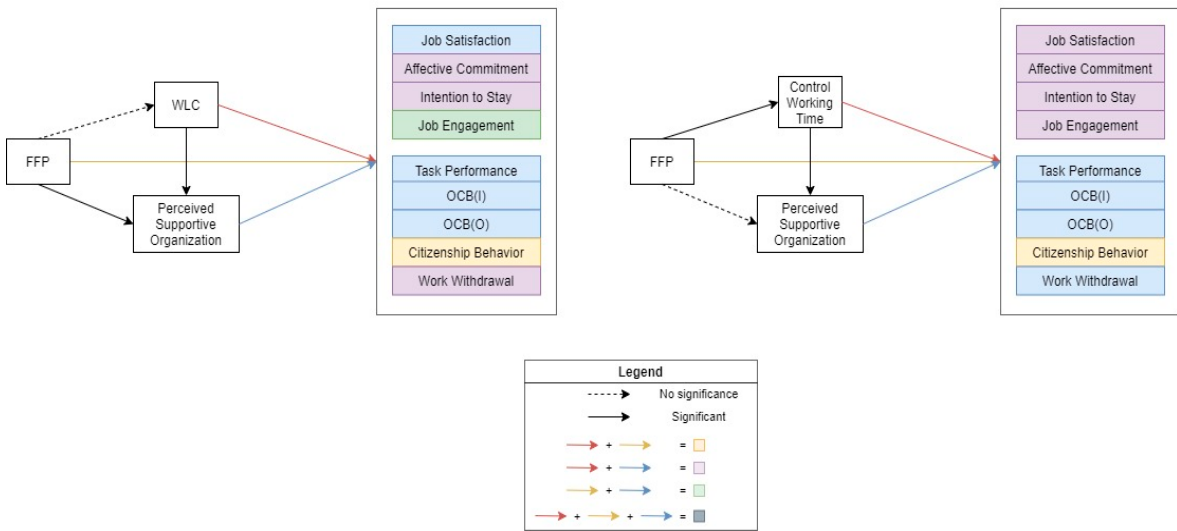
Figure 2. Association of family-friendly policies with work attitude and behavioral outcomes through the serial mediator model.